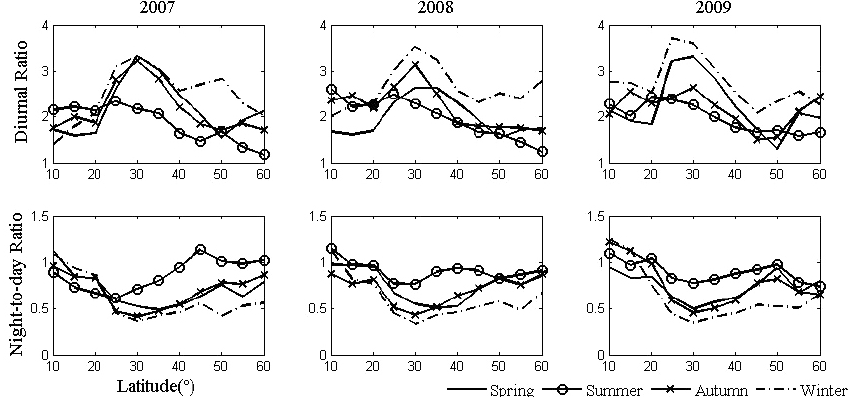
Figure 5. Latitudinal and seasonal variation in the diurnal ratio and the median night-to-day ratio for the years of 2007–2009.